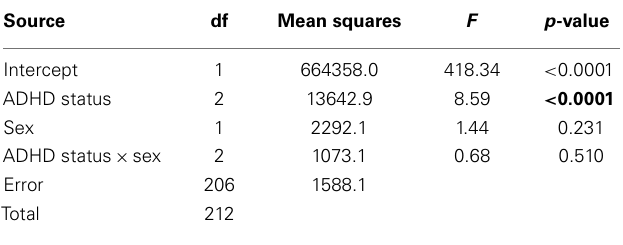
Table 5 | Summary statistics for the 3 × 2ANOVA with